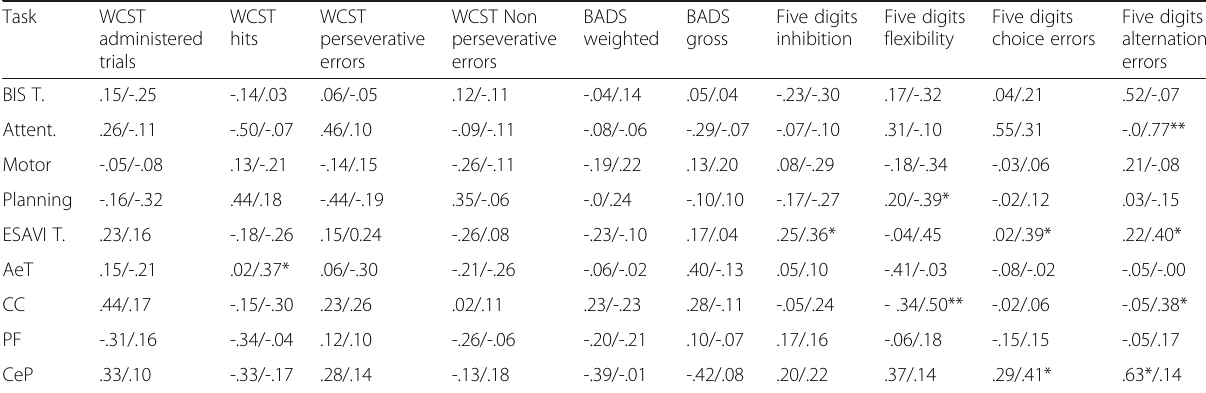
Table 5 Correlation measures among behavioral scales and executive functions evaluation tests for both clinical groups Task WCST administered